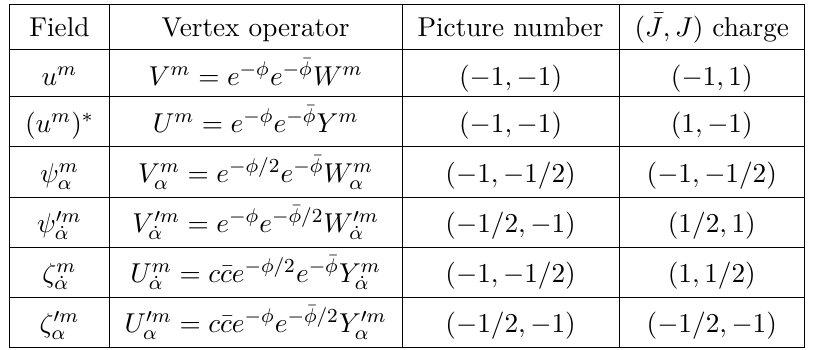
Table 1 . A list of closed string fields and vertex operators that are relevant for our analysis, their picture numbers and ( ¯ J, J )